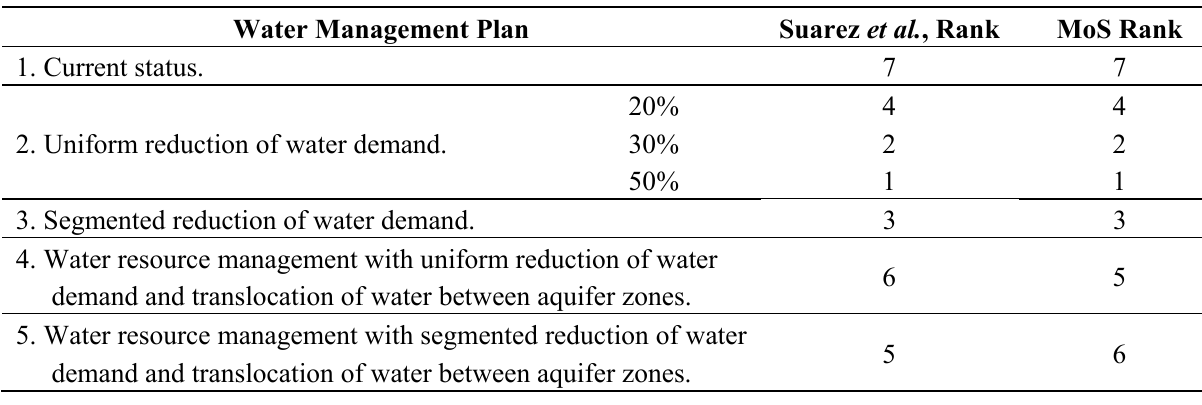
Table 7. Original plan results comparison between Suarez et al. [40] and